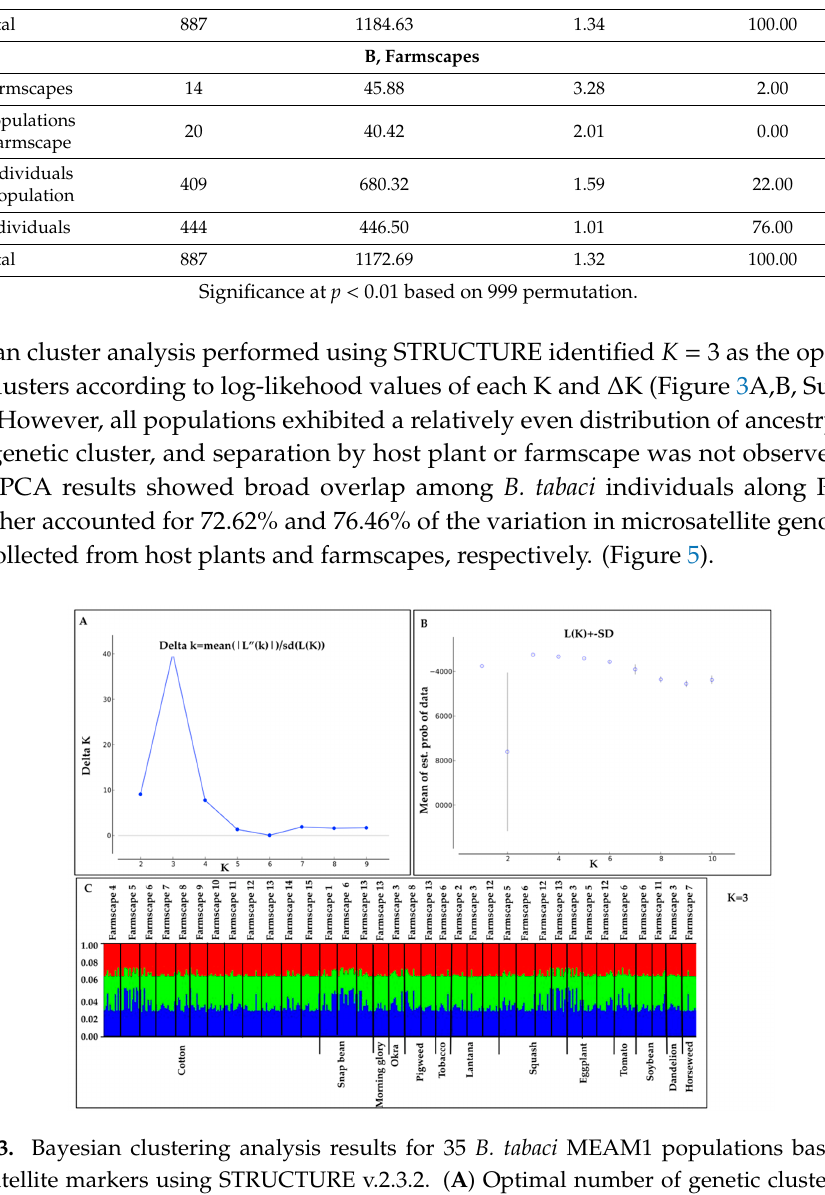
Figure 4. Pie charts showing the proportion of alleles that were inherited from a postulated ancestral population to individuals of 35 B. tabaci MEAM1 populations collected from Georgia, USA, using Bayesian clustering implemented in STRUCTURE 2.3.4 at K = 3.